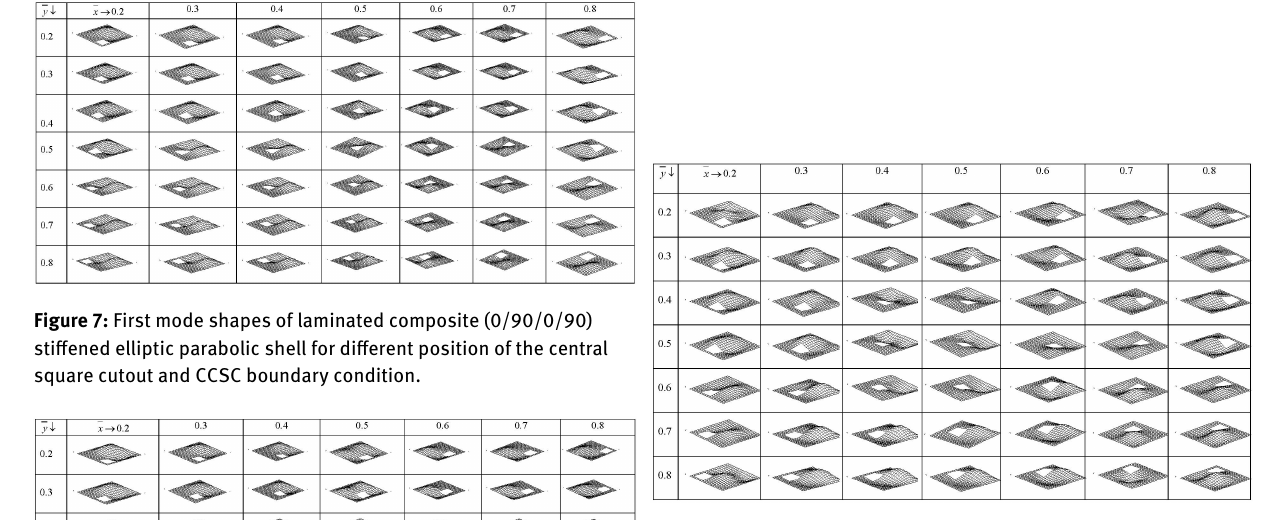
Figure 11: First mode shapes of laminated composite ( + 45/- 45/ + 45/-45) stiffened elliptic parabolic shell for different position of the central square cutout and CCSC boundary condition.